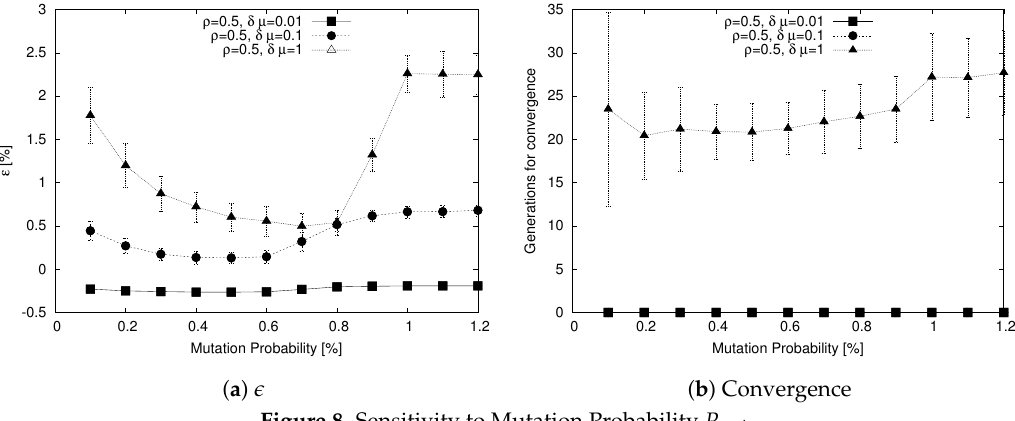
Figure 8. Sensitivity to Mutation Probability P mut